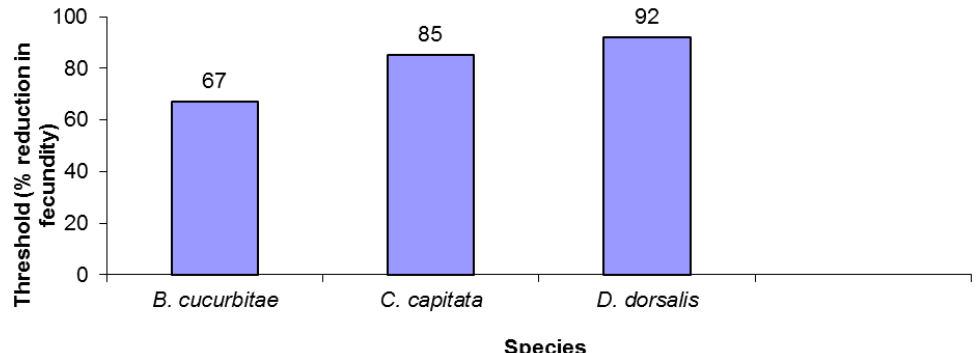
Figure 1. Extinction thresholds for three tephritid species.